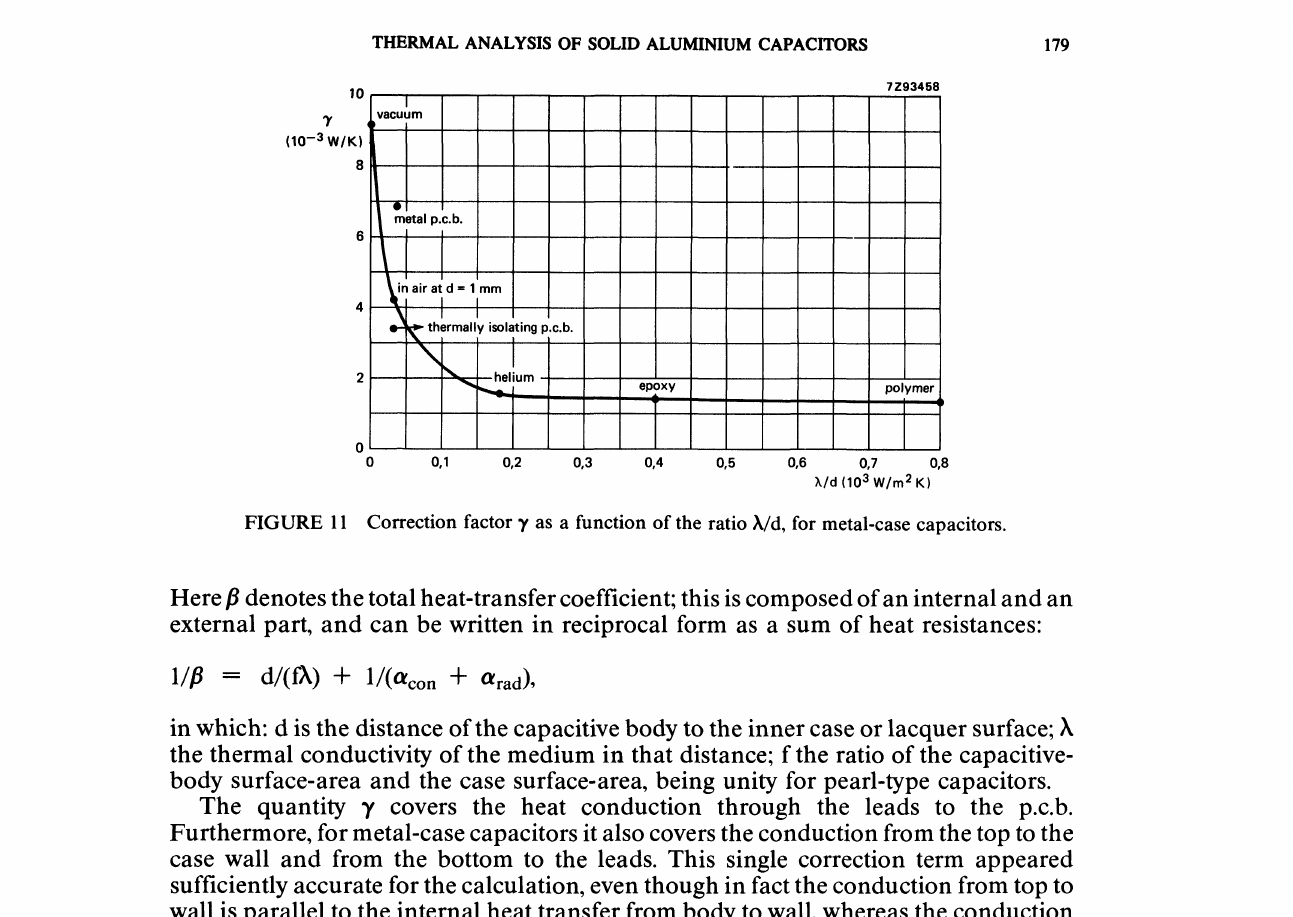
TABLE W Thermal resistances in a pearl-type